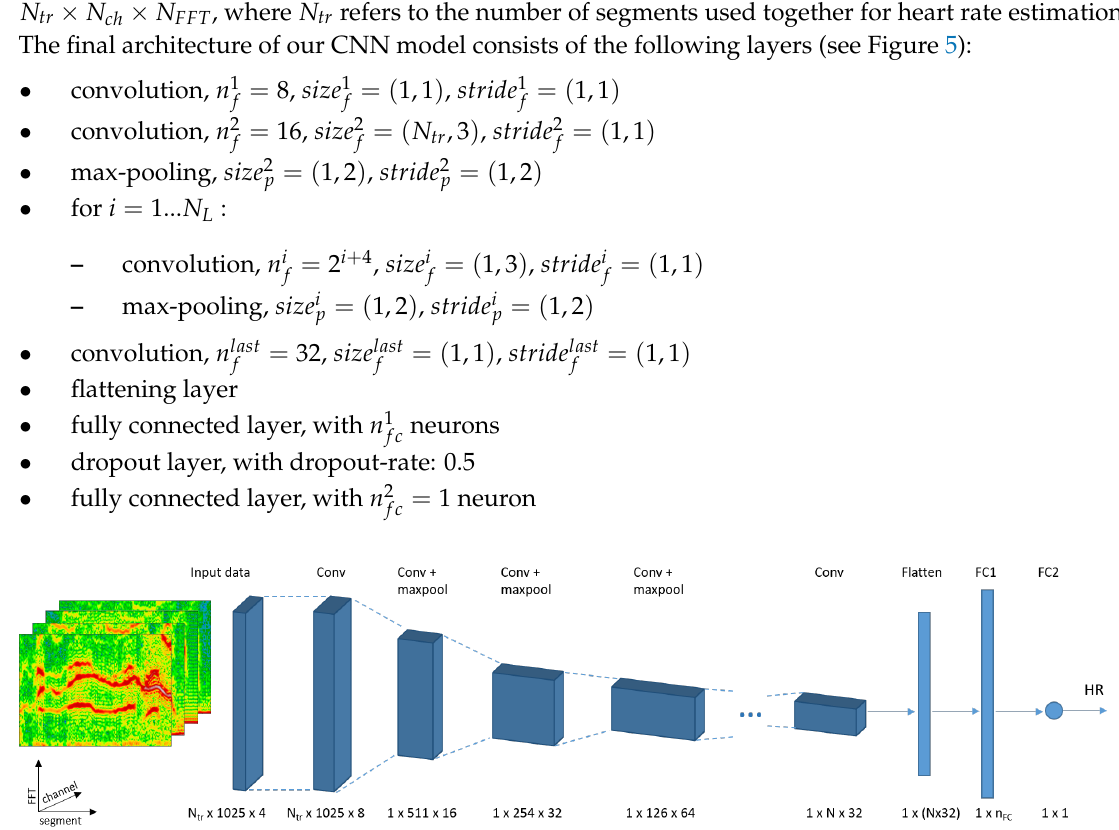
Figure 5. Proposed CNN-architecture with N L = 1 . . . 8 convolution-maxpool layers. N tr refers to the number of segments used together for heart rate tracking (see Section 4.1 for details). N depends on N L . Input: N tr × N ch × N FFT matrix. Output: heart rate